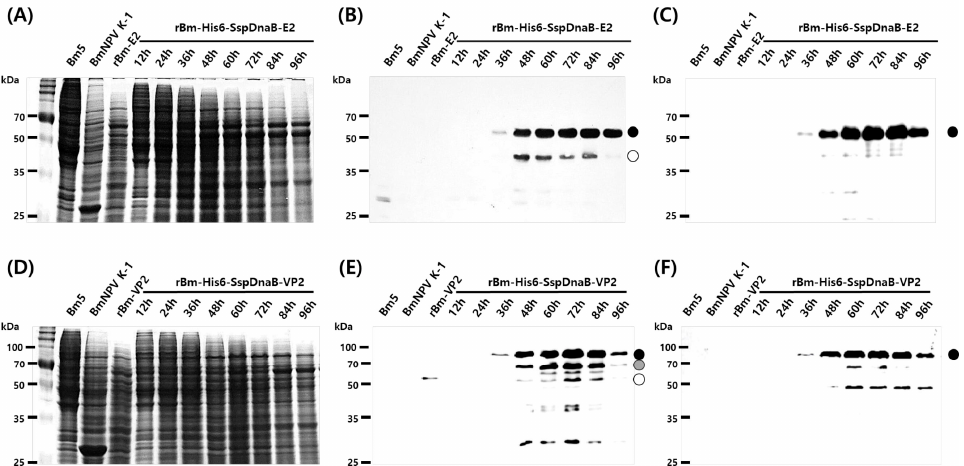
Figure 4. Bm5 cells were infected with 5 MOI of each virus and harvested from 12 to 96 h.p.i at intervals of 12 h. ( A , D ) Protein samples were analyzed by 12% SDS-PAGE ( B ) and Western blot analysis with a CSFV-E2 monoclonal antibody, ( E ) PPV-VP2 polyclonal antibody, ( C , F ) and His tag monoclonal antibody. Control samples by BmNPV-K1, rBm-E2 and rBm-VP2 were prepared at 72 h.p.i. The black circle represents the fusion-expressed recombinant protein with His6 and the Ssp DnaB mini-intein. The gray circle represents each recombinant protein released from the fusion protein by cleavage of the mini-intein. The opened circle represents degraded target proteins.